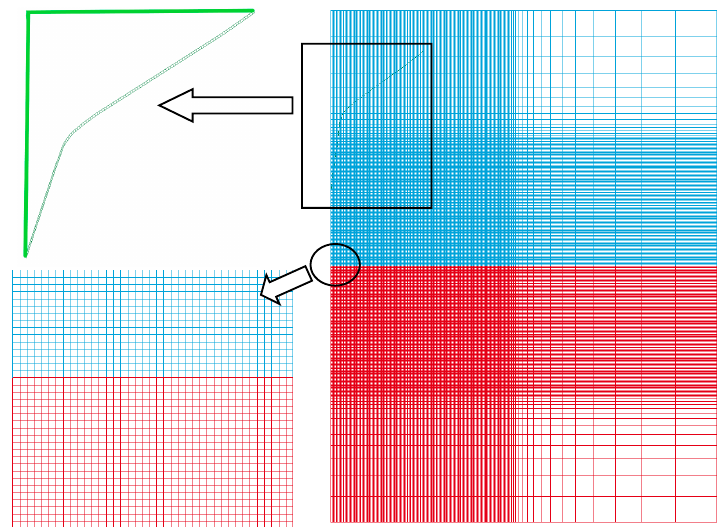
Figure 4. Grids for the section of the WILS JIP-II hull section.